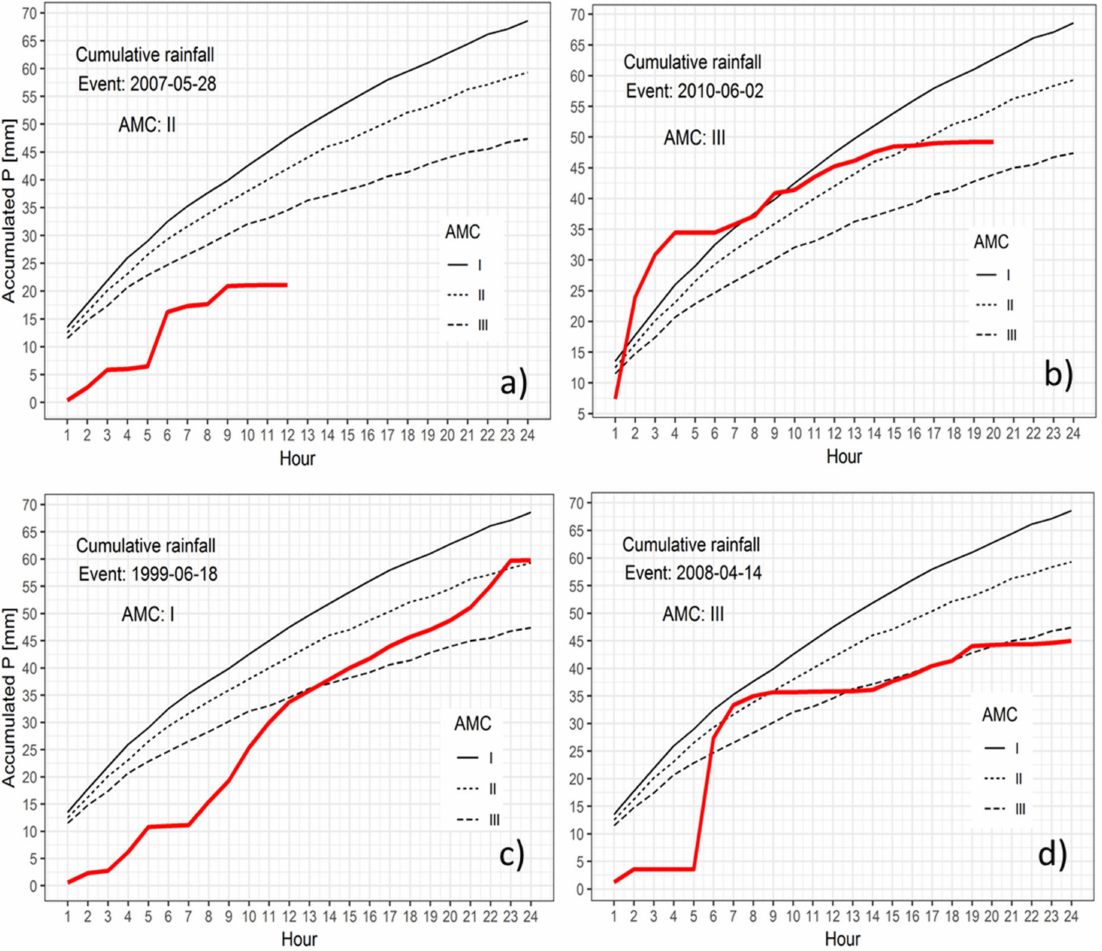
Figure 3. Application and validation of rainfall thresholds, with examples shown for four selected events with different pre-event soil moisture conditions (indicated in each sub-figure) and rain and discharge characteristics. The red lines are accumulated forecasted rainfall of the events. ( a ) Missing alarm; ( b ) correct alarm; ( c ) correct missing alarm and ( d ) correct alarm due to information on antecedent soil moisture. The categories are summarized in Table 2. The characteristics of the four selected events are listed in Table 1. The events were selected on purpose to illustrate the differences in issuing an alarm. The false alarm is not illustrated